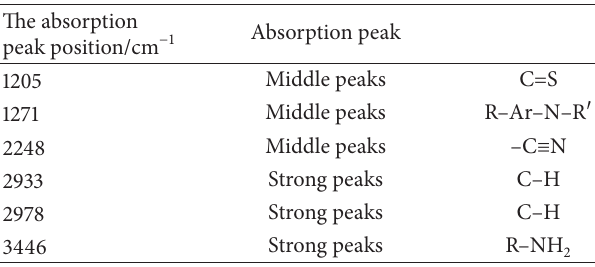
Table 1: Infrared spectrum analysis of synthetic